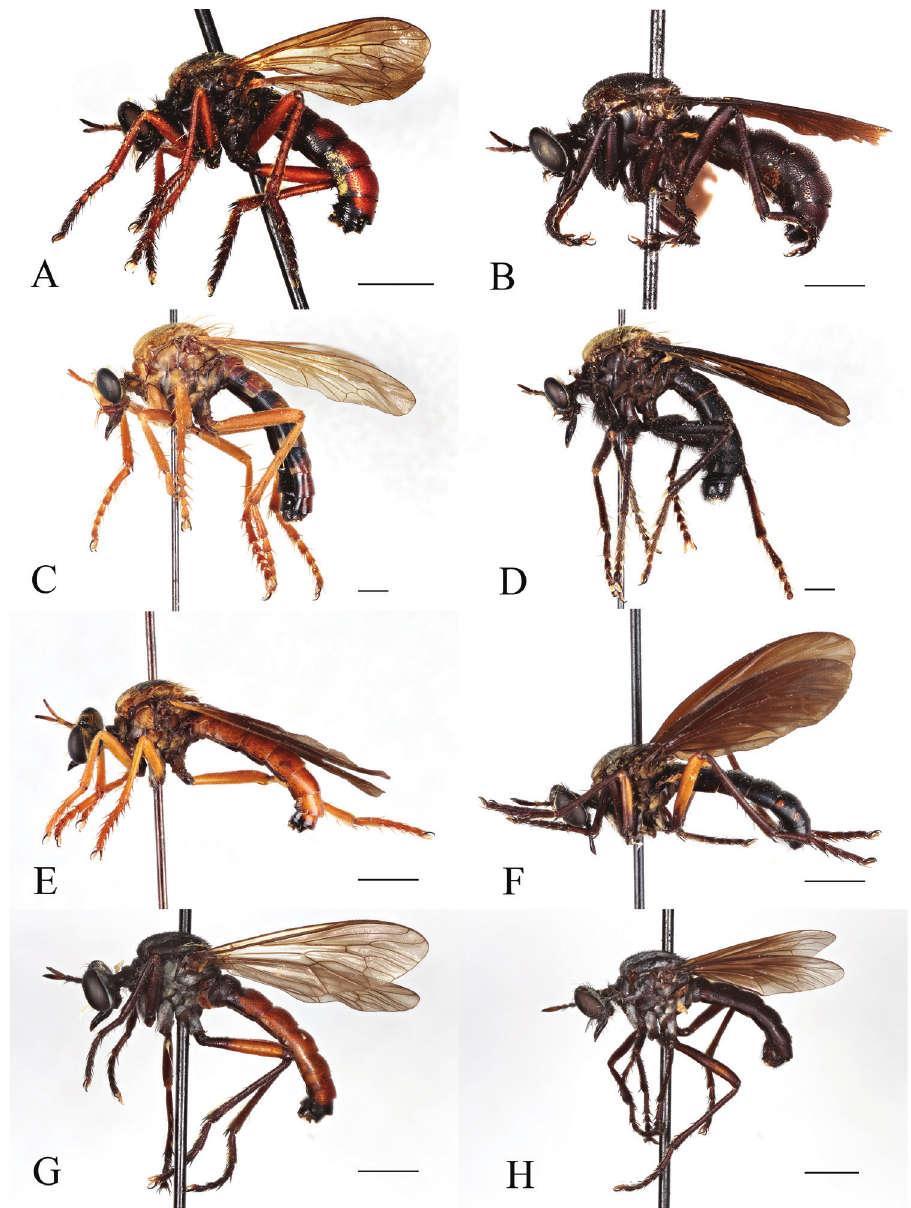
Figure 4. Sexual color dimorphism A Saropogon abbreviatus female B S. abbreviatus male C S. combustus